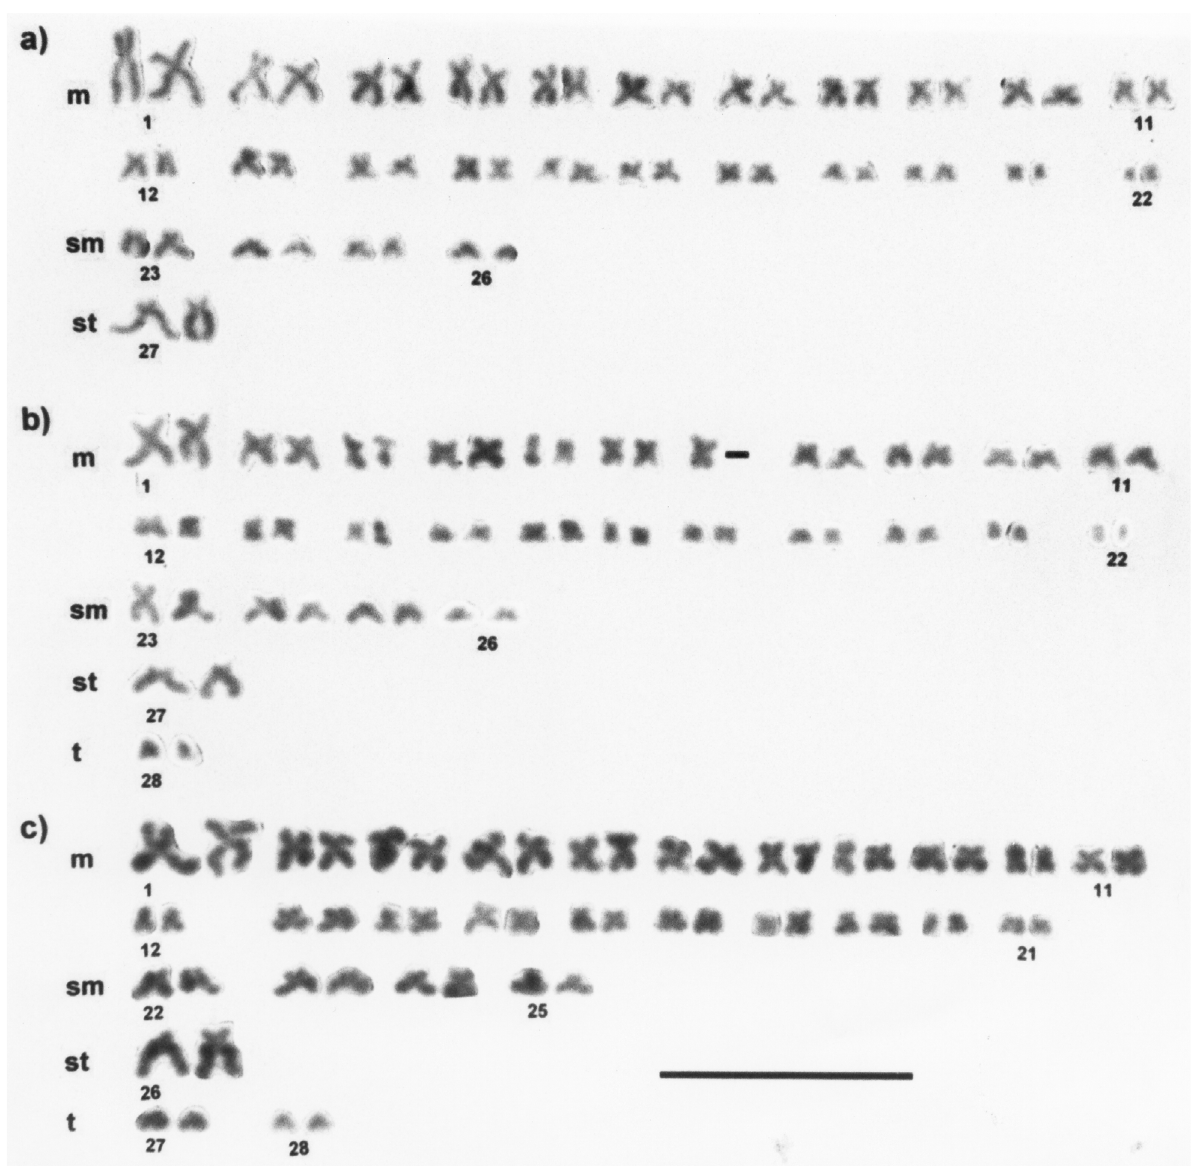
Figure 1 - Karyotypes of T. areolatus from Chile. a) Karyotype with 2n = 54 chromosomes of the Tijeral and Huilma River populations. In b) and c) karyotypes with 2n = 55 and 2n = 56 chromosomes, respectively, representing the intra-individual numerical chromosome variation observed in some specimens of the Huilma River. Chromosome morphologies: m = metacentric, sm = submetcentic, st = subtelocentric, and t = telocentric (= acrocentric). Bar represents 5 µ